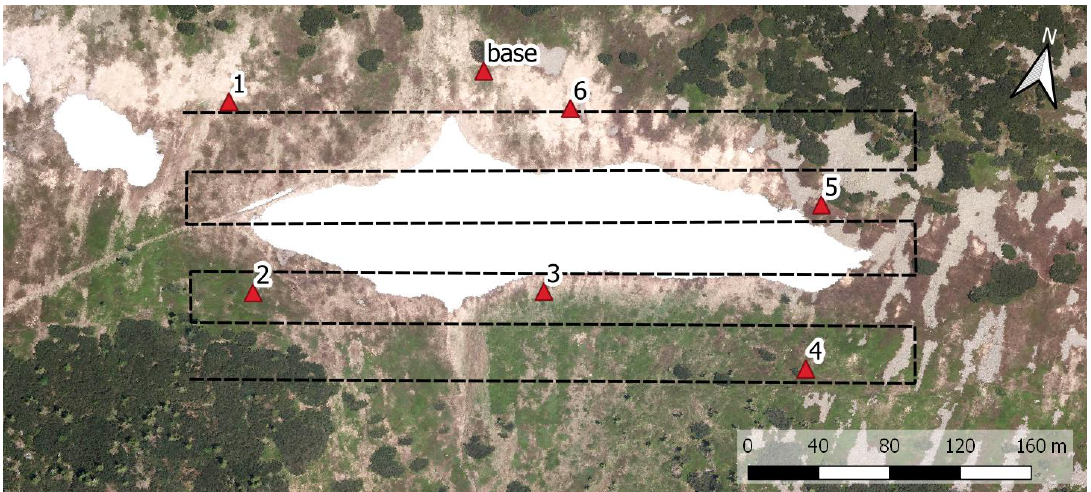
Figure 6. The locations of the ground targets and the base station, together with the flight trajectory for the UAS (the orthophoto obtained during the melting season